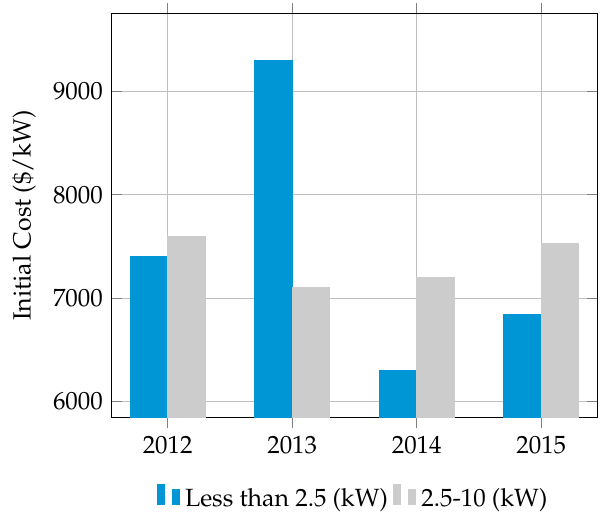
Figure 9. Initial costs for different installed capacities from 2012 to